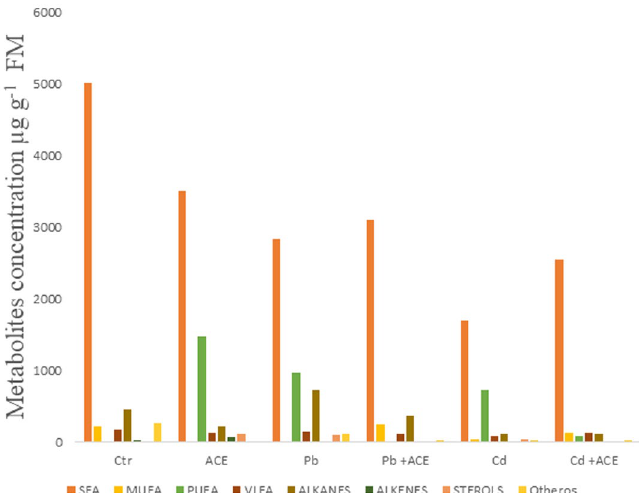
Figure 4. Effect of ACE on metabolites changes under Pb and Cd